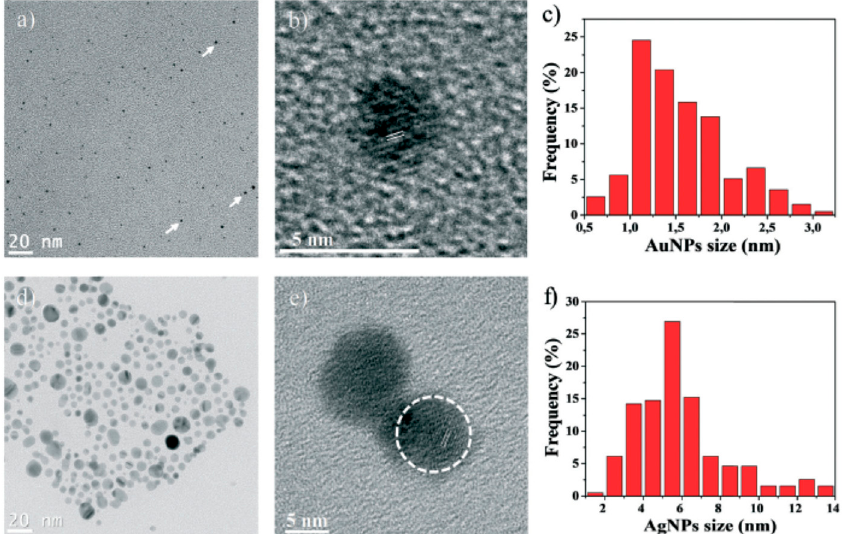
Figure 4. Nanoparticles characterization: TEM micrographs of AuNPs ( a ), AgNPs ( d ); HRTEM images of single AuNPs ( b ) and AgNPs ( e ) with corresponding lattice spacing; Size distribution histogram of AuNPs ( c ) and AgNPs ( f ) (calculated by measuring ≈ 200 AuNPs and AgNPs). (Reprinted from [19]–Reproduced by permission of The Royal Society of Chemistry).